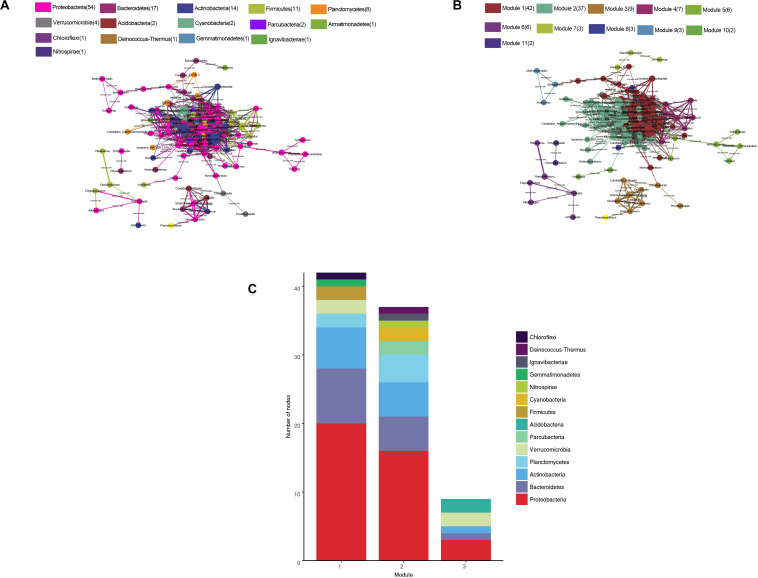
Network of co-occurring bacterial genera (relative abundance >0.05%) based on the correlation analysis. A connection represents a strong (Spearman’s r > 0.6) and significant (P < 0.01) correlation. The size of each node is proportional to the relative abundance; the thickness of each connection between two nodes (edge) is proportional to the value of the Spearman’s correlation coefficients. (A) Co-occurring network colored by phylum. (B) Co-occurring network colored by modularity class. (C) The first three modular species are composed.